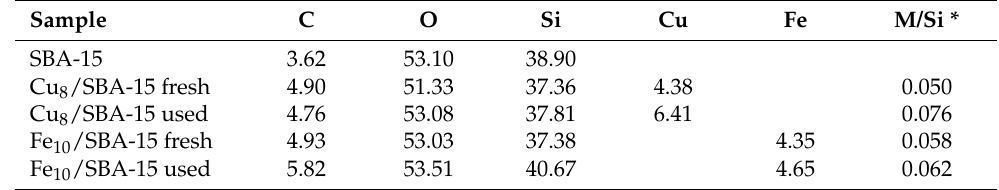
Table 4. Surface chemical composition (in wt.%) of the selected samples determined by XPS. Sample